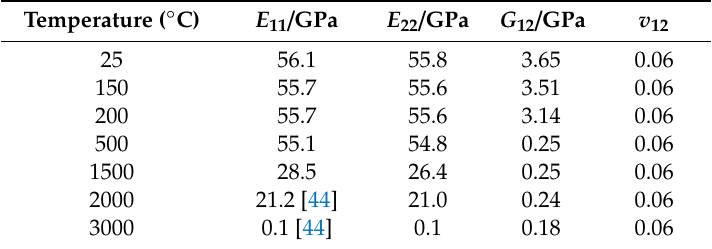
Table 5. CYCOM 970 / PWC mechanical properties vs.